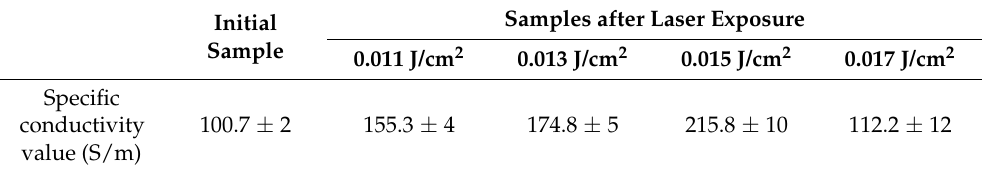
Table 3. Electrical conductivity of samples with and without laser